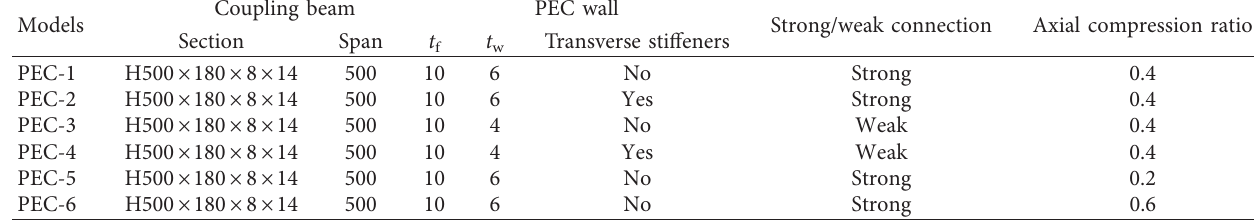
Table 1: Structural member dimensions and design properties in the